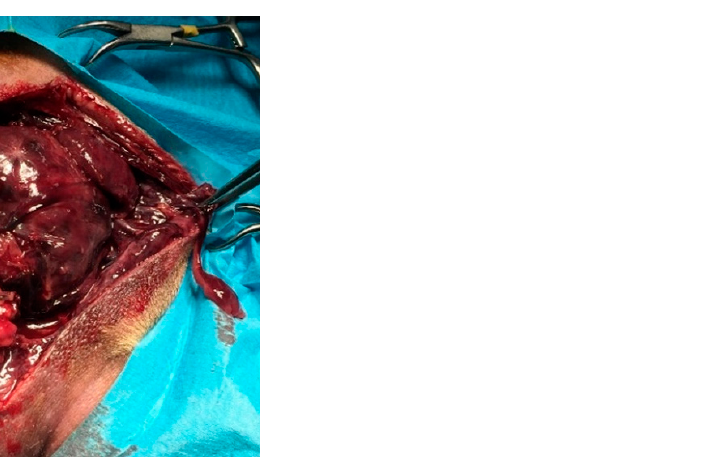
Figure 5. 8-year-old mixed breed dog. Prostate displacement in the hernial contents: macroscopic appearance of the gland. Table 1. Signalment, hernia and prostatic localization details, clinical findings for dogs undergone perineal prostatectomy.